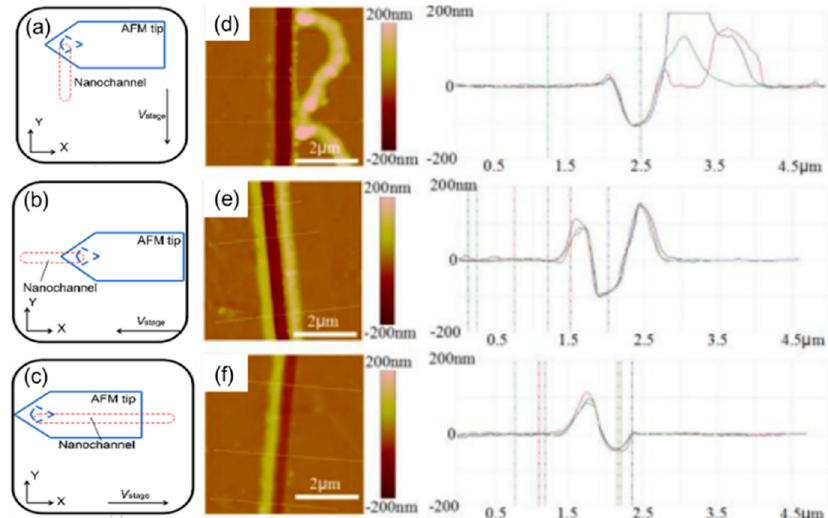
Figure 10. The influence of three feed directions on the formation of pile-up fabricating on PMMA bulk sample: ( a ) along positive direction of y -axis, ( b ) along positive direction of x -axis, ( c ) along negative direction of x -axis, the opposite direction of ( b ), ( d ), ( e ), ( f ) the AFM image of nanochannels fabrication along the directions of ( a ), ( b ) and ( c ) [88] .